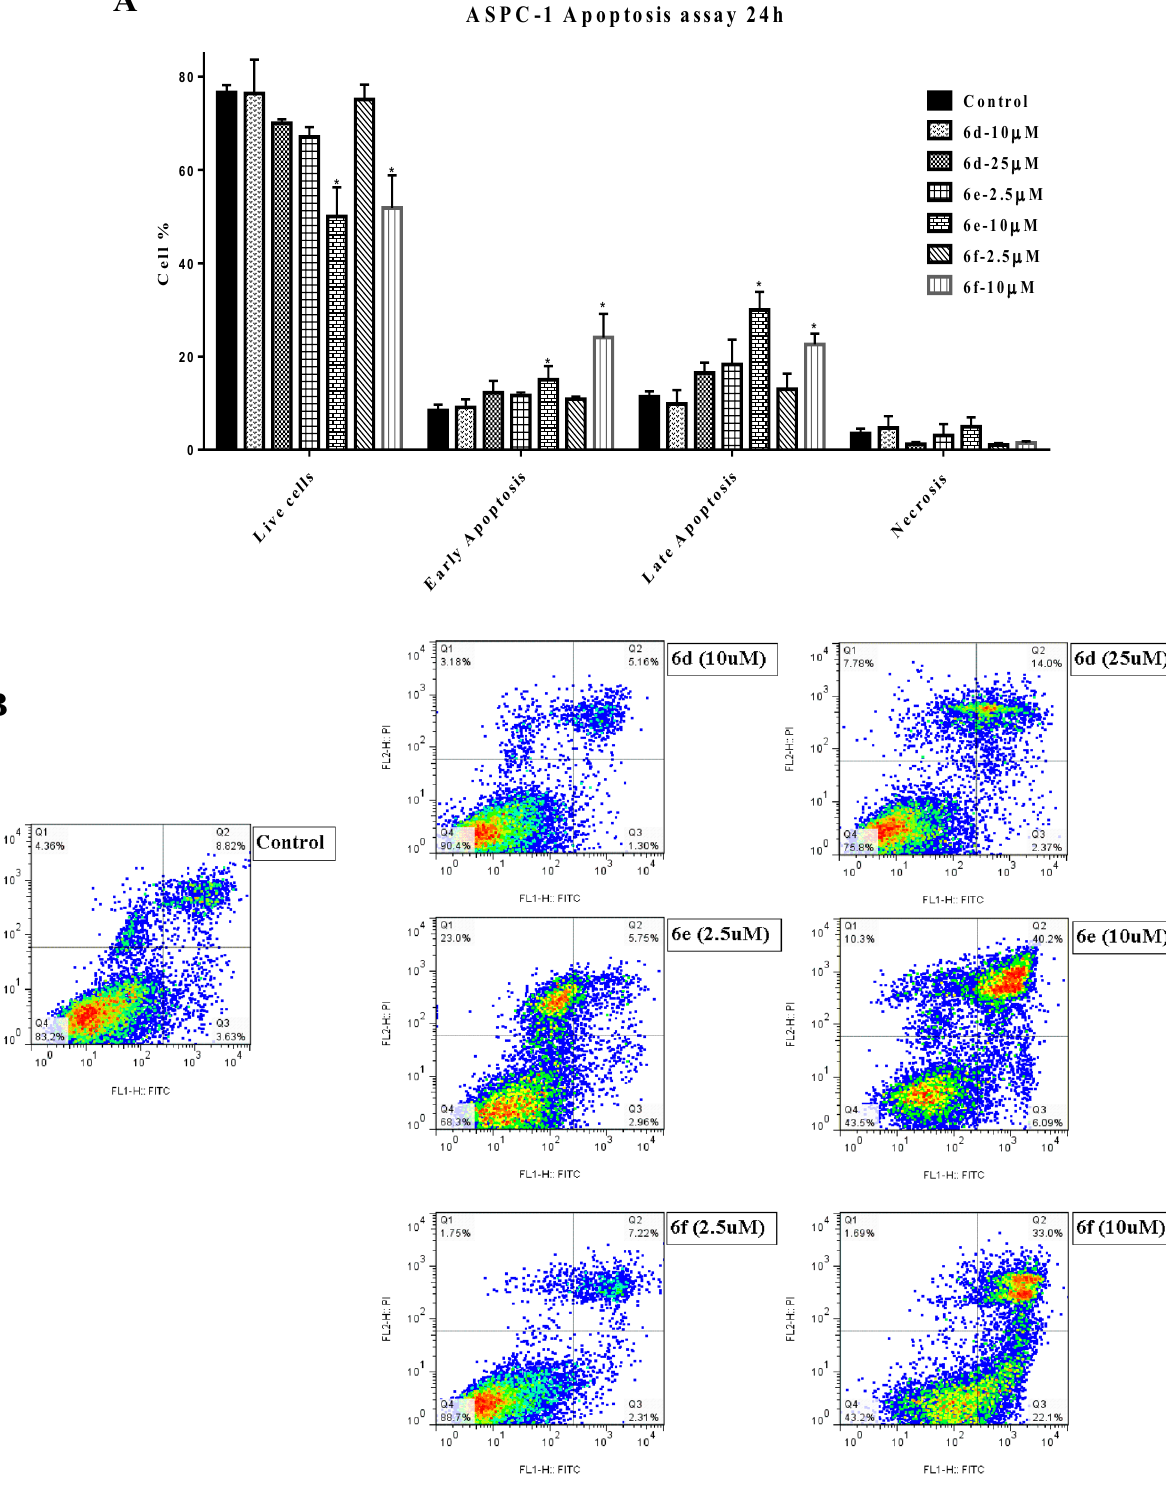
Figure 6. Apoptosis inducing effect of synthesized derivatives on AsPC-1 cancer cells. AsPC-1 cells were treated with compounds 6d (10 and 25 µM), 6e (2.5 and 10 µM) and 6f (2.5 and 10 µM) for 24 h. Apoptosis was determined in cancer cells by annexin V FITC/PI assay and measurements were performed by flow cytometry. ( A ) Each bar represents the average percentage of cells present in each of the 4 quarters ± S.E.M. Data are presented as mean ± S.E.M. of 3 replicates. *Denotes a statistically significant difference between drug- treated cells and untreated control ( p < 0.05). ( B ) Representative dot plots of AsPC-1 cells treated with different concentrations of synthesized derivatives and monitored by FACS